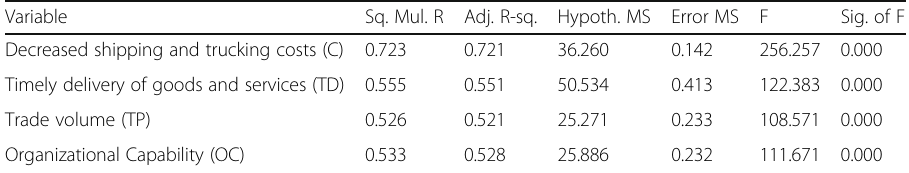
Table 9 Strength of the Models Created Variable Sq. Mul. R Adj. R-sq. Hypoth. MS Error MS F Sig. of F Decreased shipping and trucking costs (C) 0.723